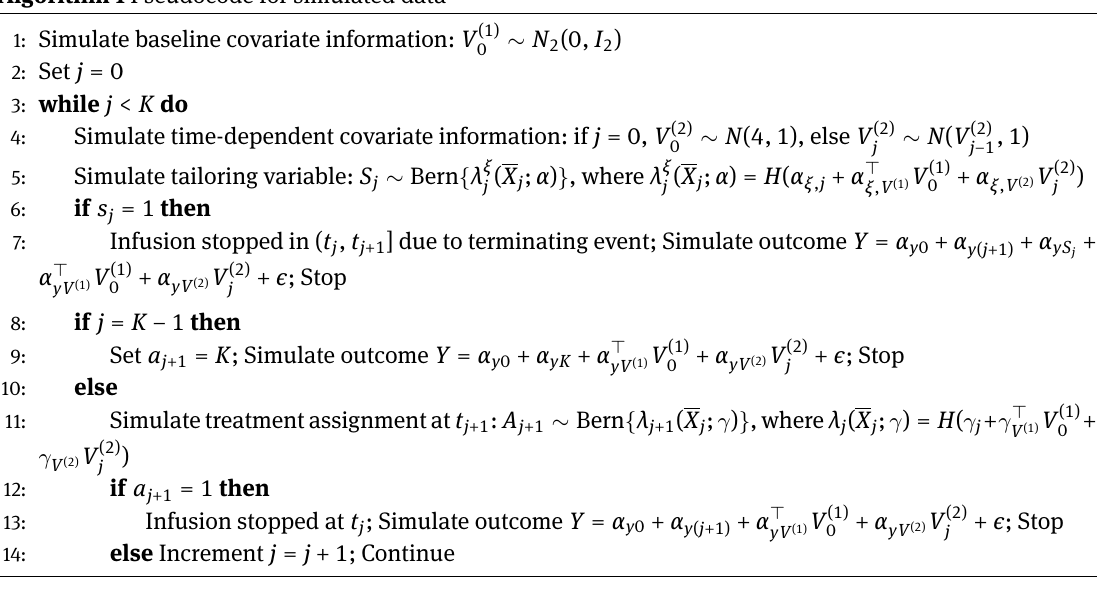
Algorithm 1 Pseudocode for simulated